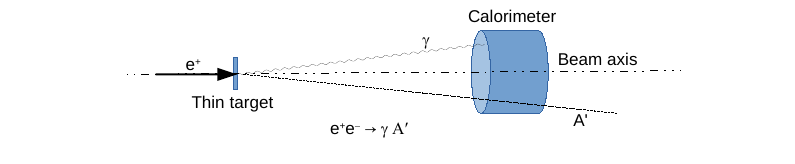
Figure 1. Searching for Dark photon with missing mass technique in positron-on-target setup.